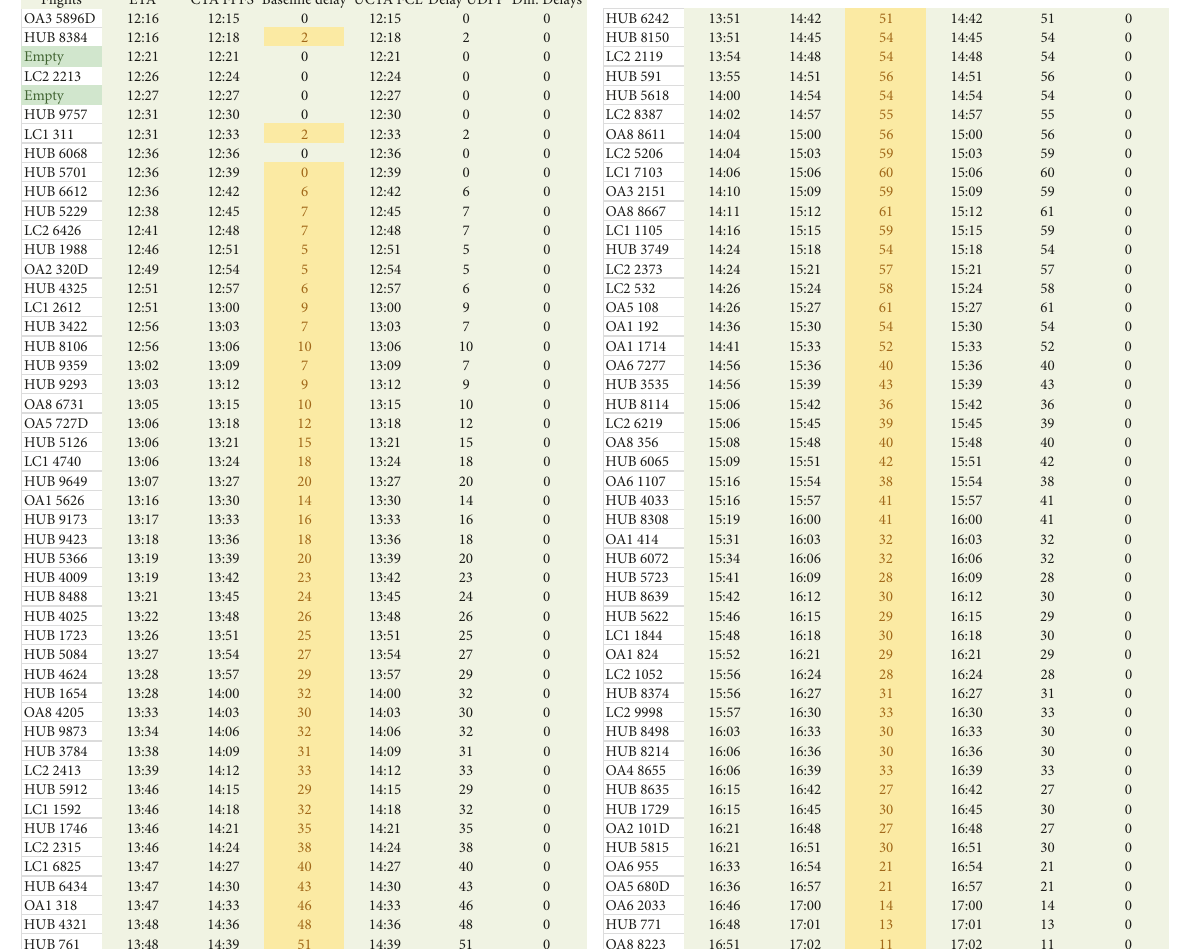
Figure 8: Schedule list with ETAs, CTAs, and calculated